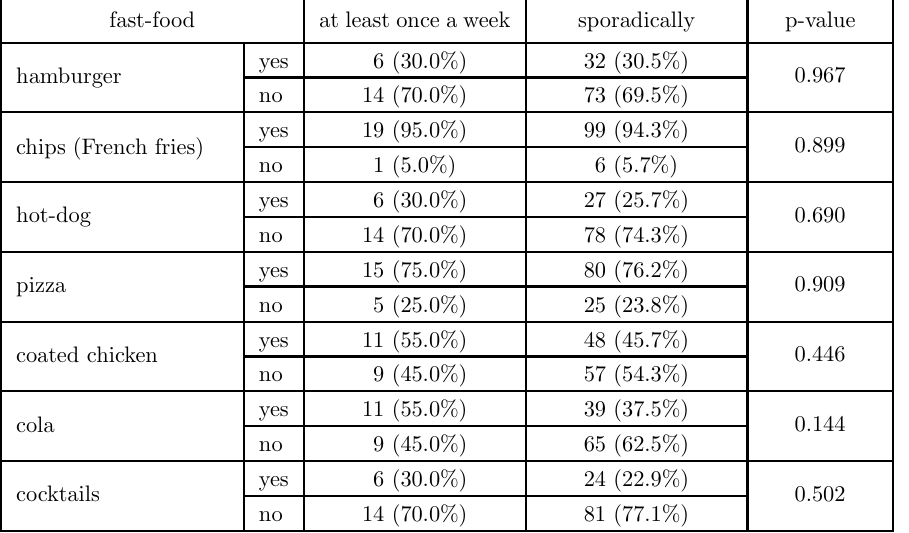
Table 4. Types of fast-food products consumed by